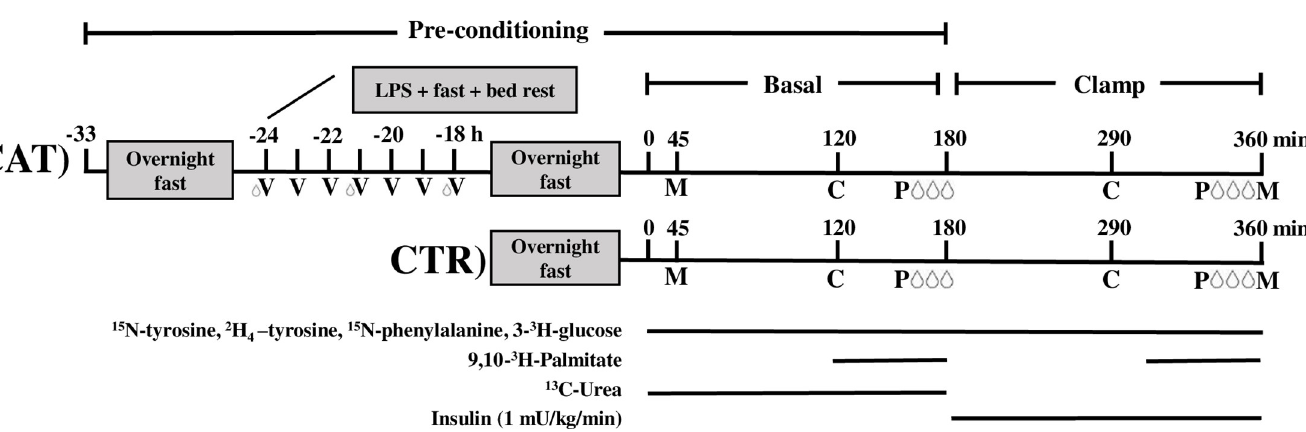
PLOS ONE | https://doi.org/10.1371/journal.pone.0241274 November5,